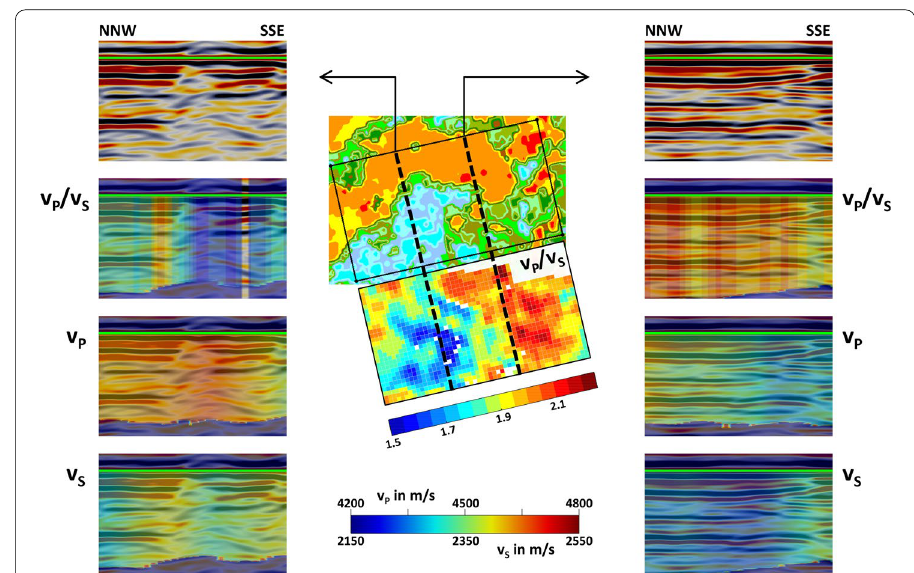
Fig. 12 Correlation of reflectivity, velocity and v p /v s . Two P-wave seismic sections (left and right) from the conventional 3D seismic, overlain with v p / v s ratio, v p and v s velocities. Center; seismic facies classification and v p /v s ratio from Fig. 11, showing position of the sections. The sections were chosen because of their different v p / v s ratios and seismic facies classifications. v p /v s shows a good correlation with P-wave reflectivity. The v p / v s ratio was derived using the interval traveltimes (Eq. 2), whereas the smoothed velocities (v p , v ps ) were determined using interactive velocity analysis, from which v s was derived using Eq. 3. Top Upper Jurassic (Top Priabonian) horizon is indicated by the green line. The sections are flattened to Top